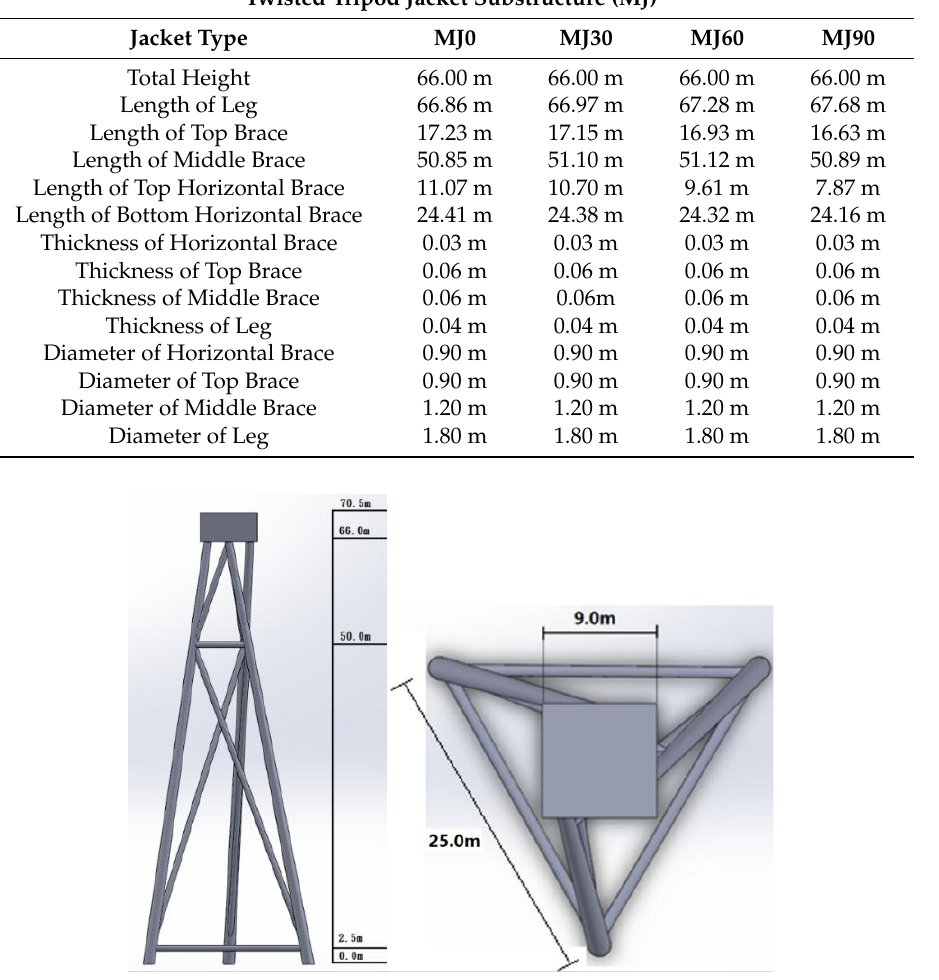
Figure A9. Side and top views of the 60° tripod (MJ60) structure.